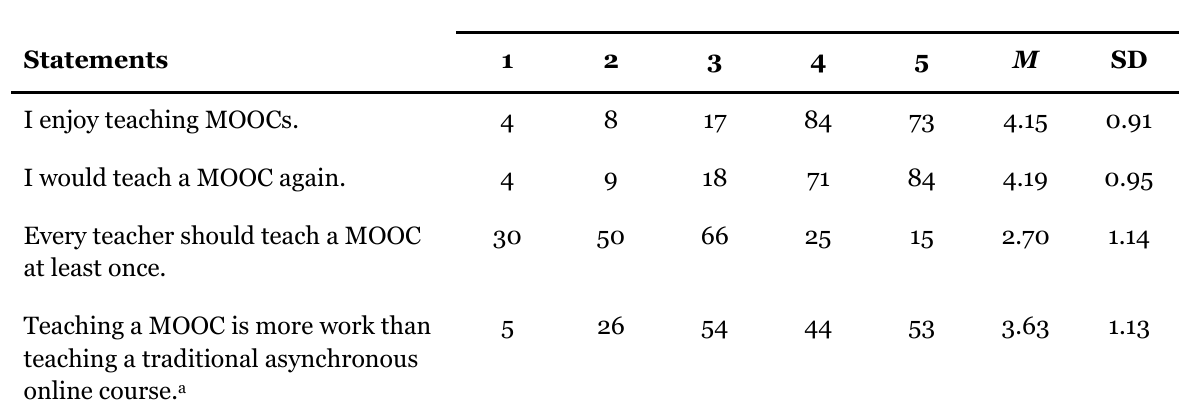
Satisfaction With MOOC Teaching